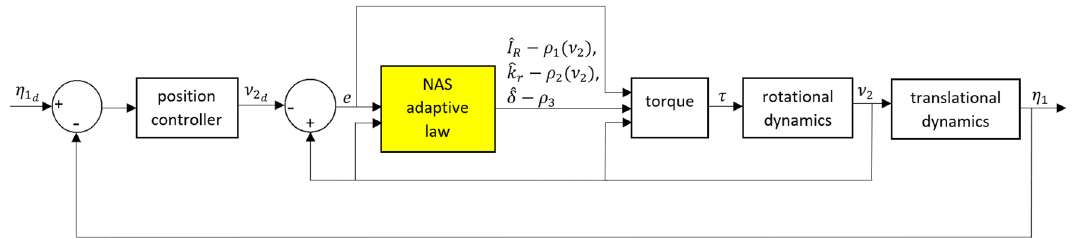
Figure 3. The control system design for a 6-DOF UAV using NAS.